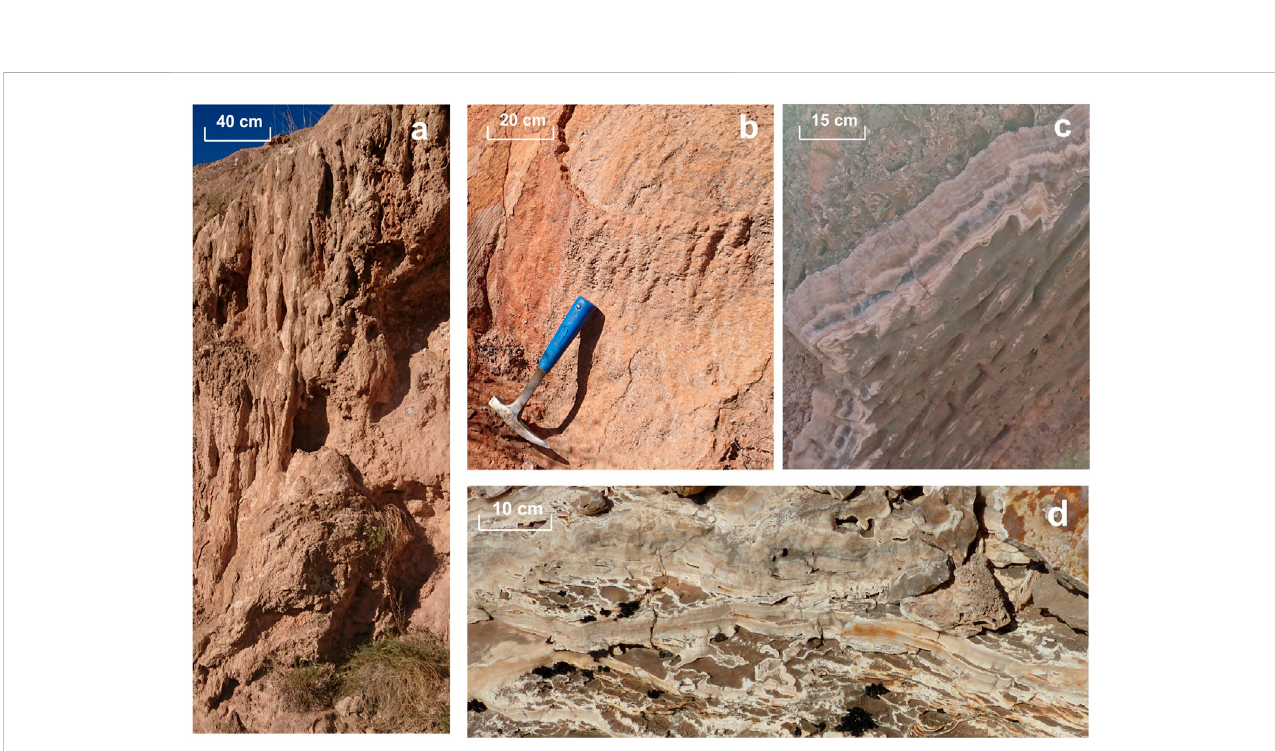
FIGURE 4 Field images of the different outcrops in Carraclaca site. (A) Fluvial scarp where travertine precipitates with cascade-type morphologies. (B) Fault scarp related to the pop-up structure where travertines with cascade morphotypes precipitate. (C) Banded travertine of fracture or fault fi lling. It shows crystalline crustal lithofacies. (D) Bedded travertine with crystalline crust.